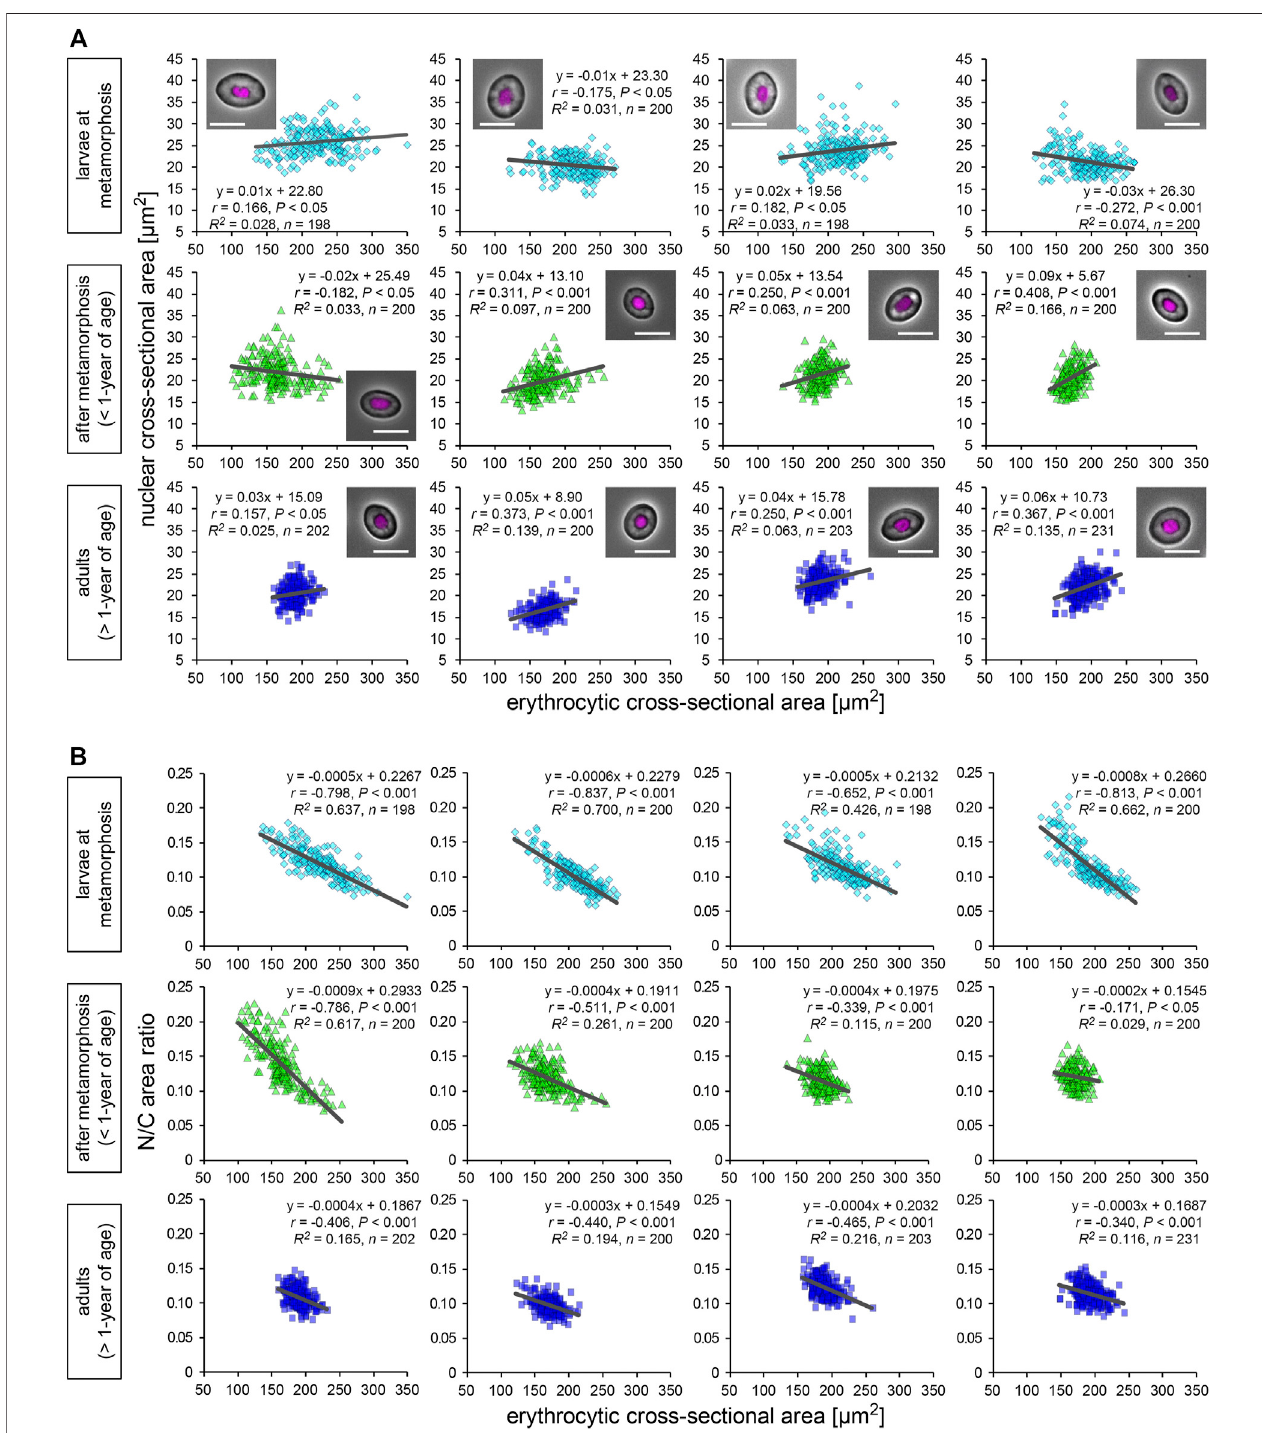
FIGURE 1 | Nuclear and erythrocytic cross-sectional areas from X. laevis individuals. (A) Measured nuclear cross-sectional areas were plotted against the erythrocyticcross-sectionalareas.Eachsymbolcorrespondstodatafromeacherythrocyte.Theplotsshowthedatasetsfrom X.laevis individualsatthestagesoflarvae during metamorphosis (light blue), young adults (green), and fully grown adults (blue). A merged image of an erythrocyte with Hoechst 33342 (magenta) staining and phase contrast is shown in each graph. Scale bar = 10 μ m. The equation for the regression line, sample number ( n ), Pearson ’ s correlation ( r ), P values, and the coef fi cient of determination ( R 2 ) have been indicated in each plot. (B) Calculated ratios of nuclear cross-sectional area to erythrocytic area (N/C area ratio) have been plotted against the measured erythrocytic areas.